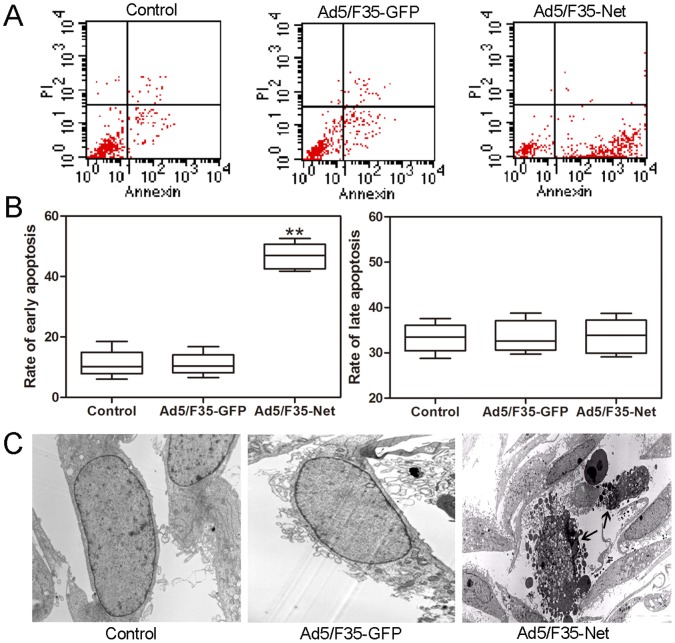
Net induces the apoptosis in pancreatic ductal carcinoma cell PL45.(A) Cell apoptosis was examined in PL45 cells after 48 hours of Ad5/F35-Net transfection using AnnexinV/PI method. (B) The rates of early and late apoptosis were evaluated after 48 hours of Ad5/F35-Net transfection. (C) Ultrastructures of cells were observed by transmission electron microscope. Concentrated phenomena of cytoplasm, karyopyknosis, karyorrhexis and apoptotic body formation were detected in PL45 cell transfected with Ad5/F35-Net, no obvious changes was observed in control group and Ad5/F35-GFP group. Black arrow indicated karyopyknosis andkaryorrhexis. *p<0.05, **p<0.01.